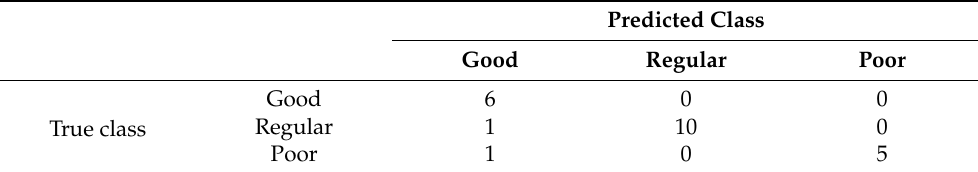
Table 10. Confusion matrix of the proposed meta-learning for the MLP classifier.